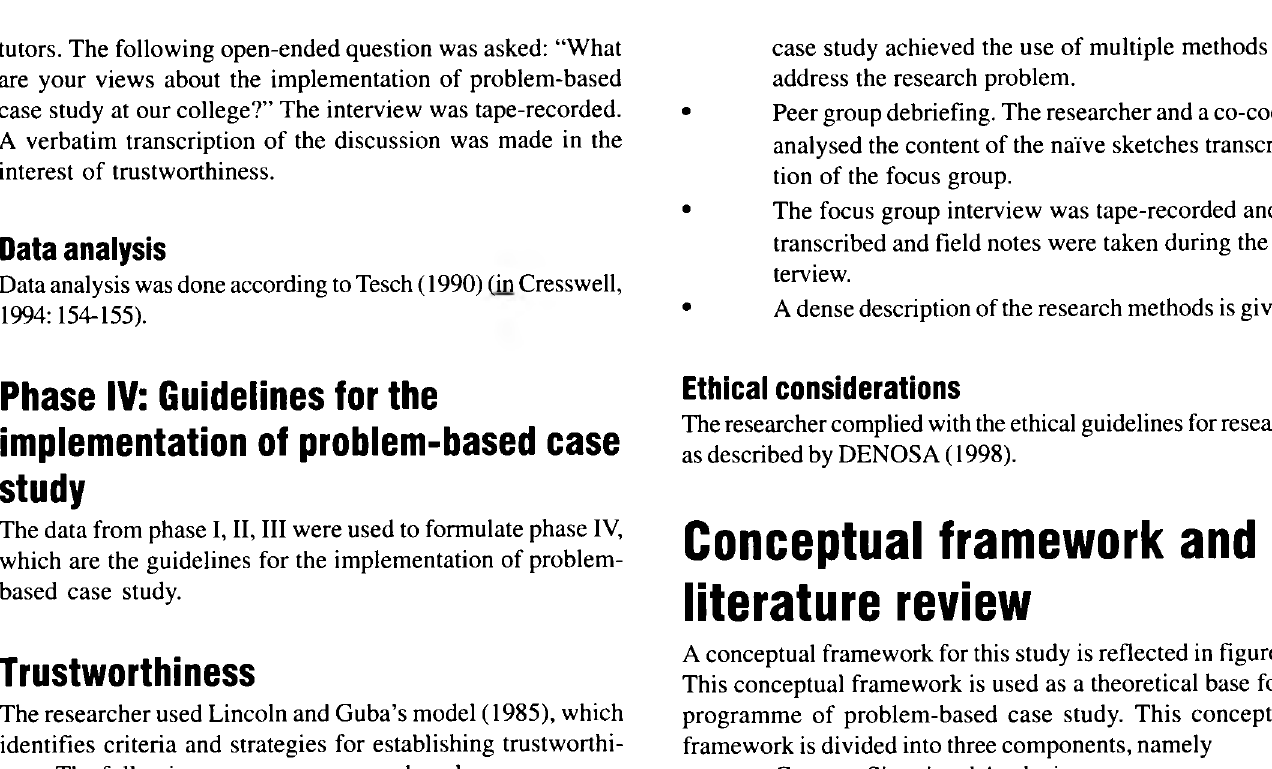
Figure 1 Conceptual framework of the